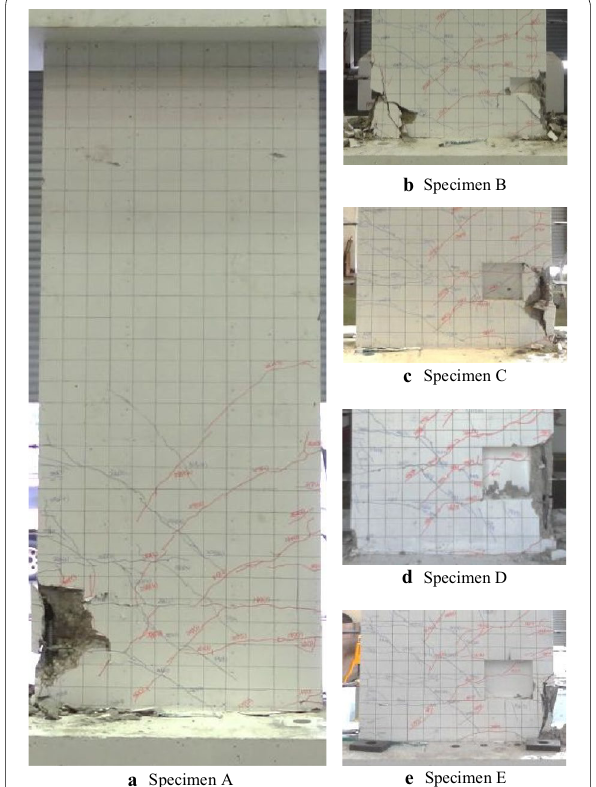
Fig. 9 Crack and failure mode of specimens at the end of the test.